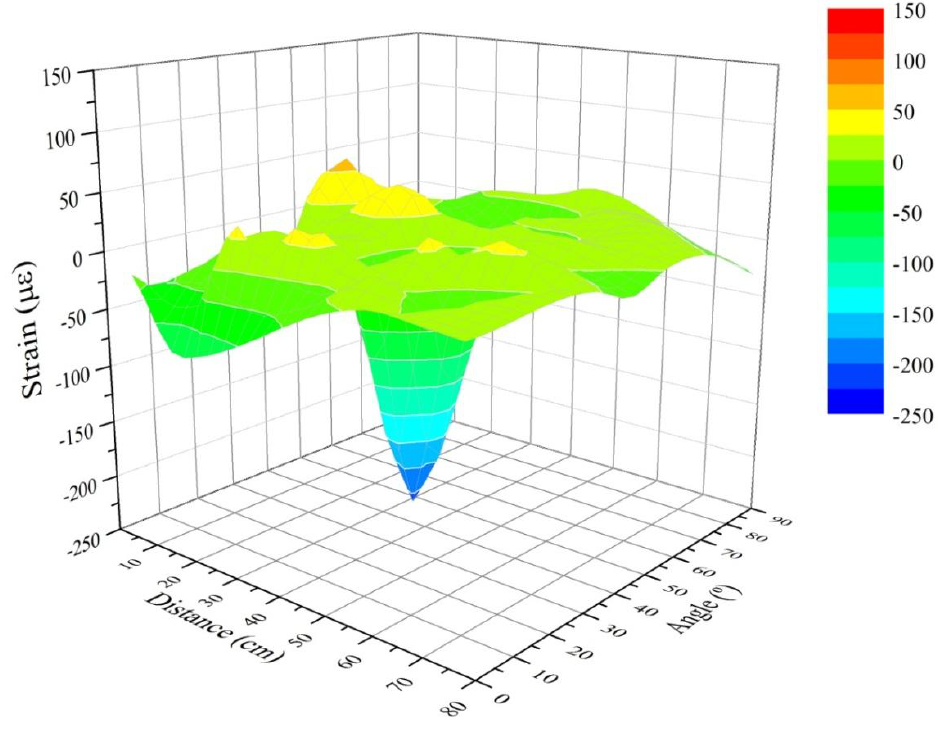
Figure 5. Residual strain with the mass of 2.5 kg.